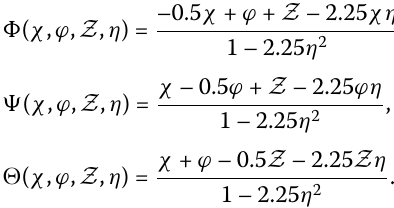
Fig. 14 of (cid:14) the exact and analytical solutions at ϒ = 1 show close contact with each other.